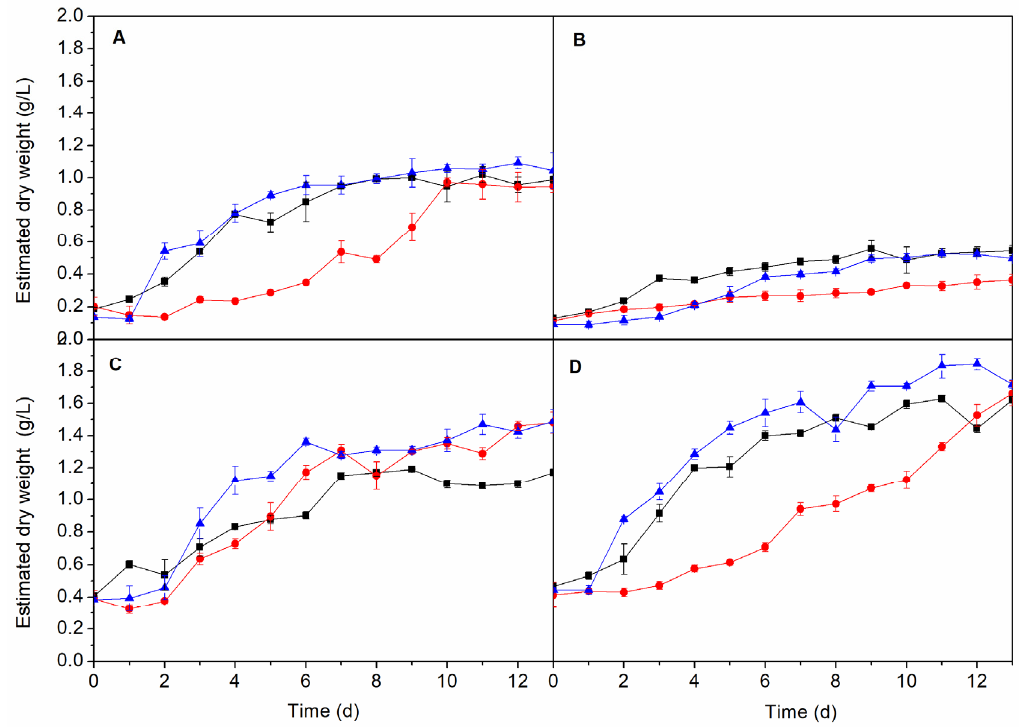
Figure 2. Growth of A. maxima ( A ), C. vulgaris ( B ), I. galbana ( C ) and N. gaditana ( D ) at different light:dark photoperiod ( ● 6:18, ■ 12:12 and ▲ 18:6 h).